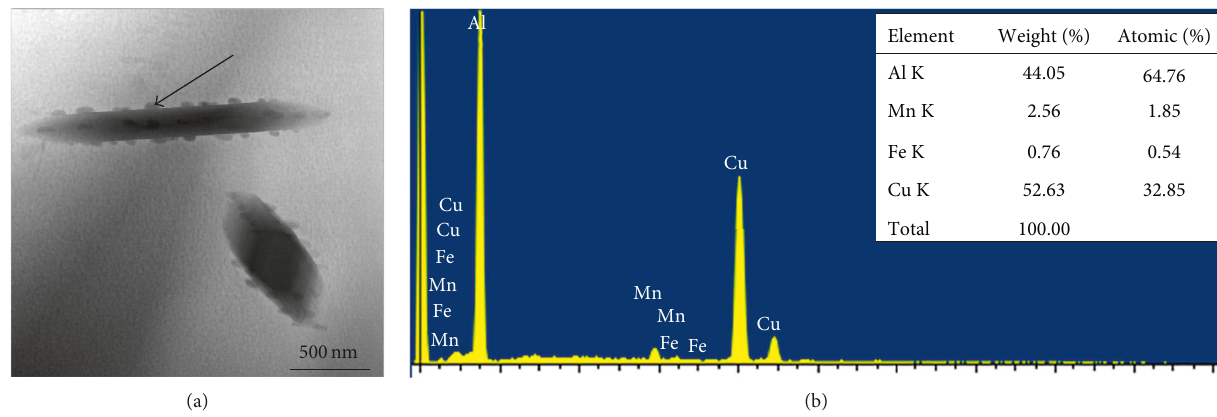
Figure 11: TEM image showing very fine precipitation particles around/on the rod-like T EDS results